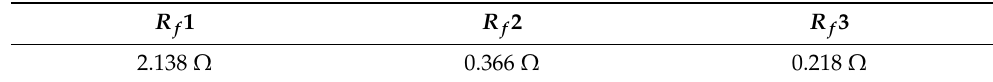
Table 3. Used R f in the